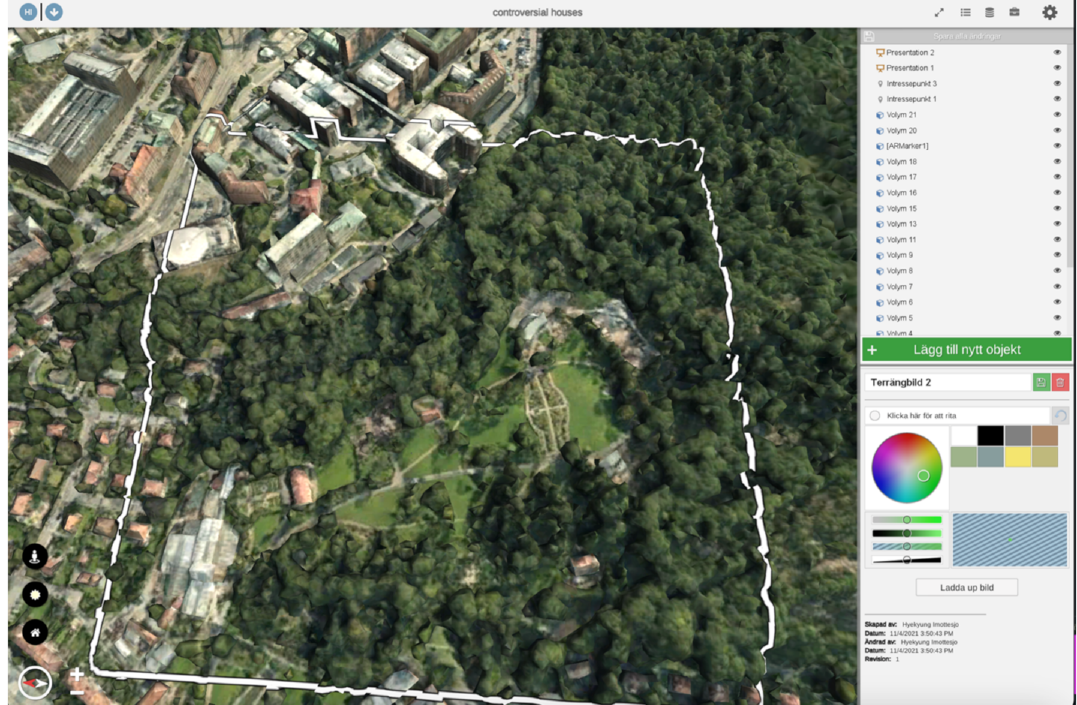
Figure 10. The terrain image function when placing objects, allowing users to draw 2D lines on the